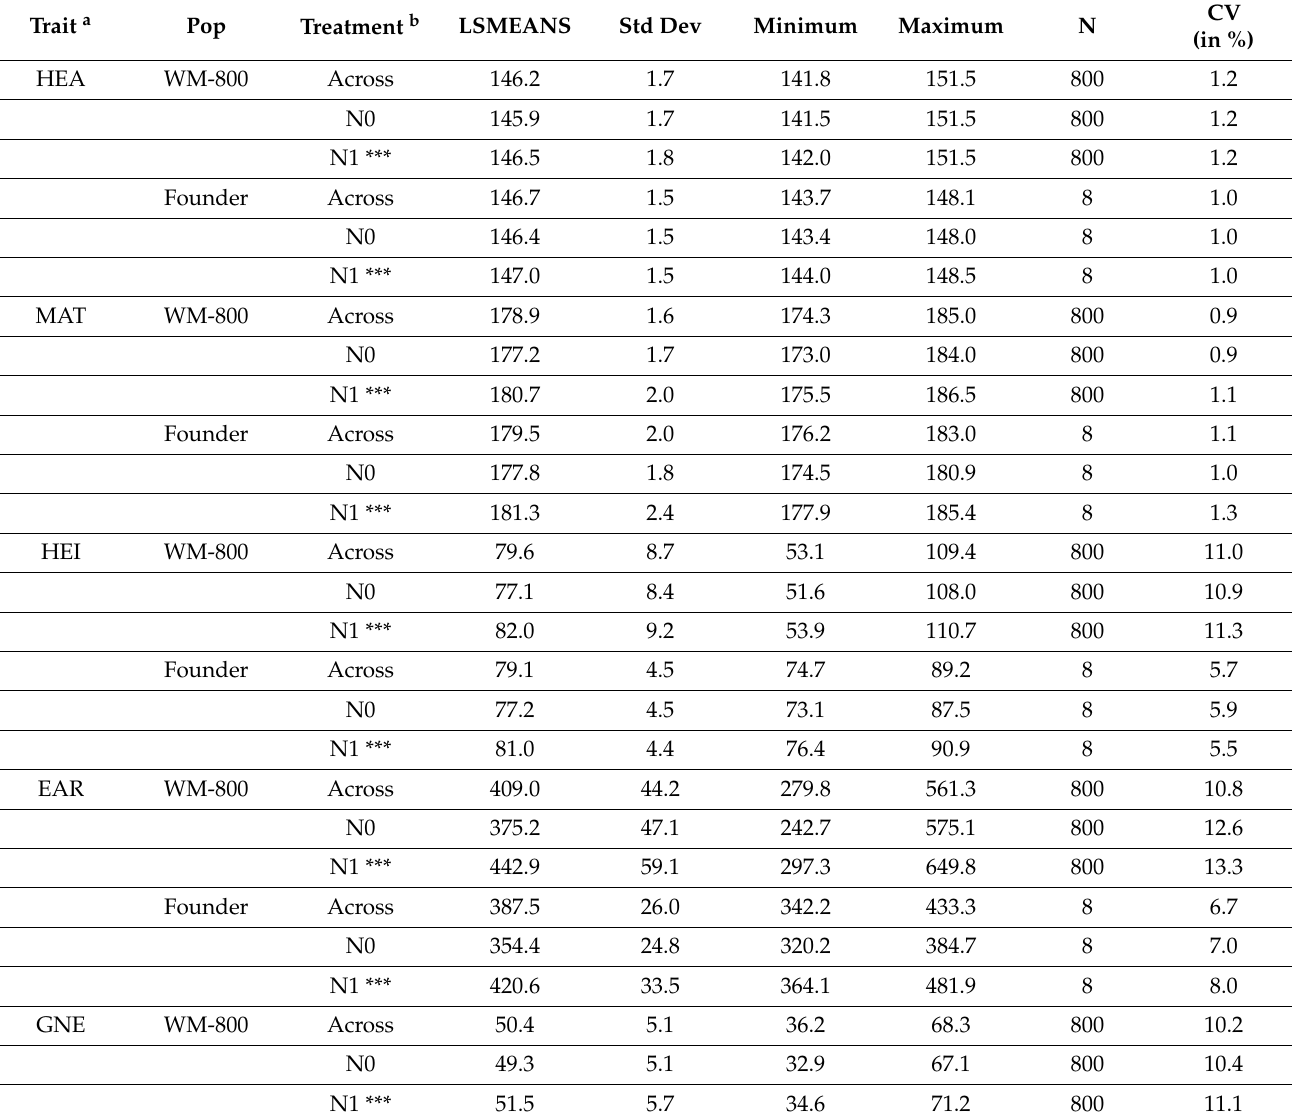
Table 1. Descriptive statistics of traits studied in population WM-800 and in